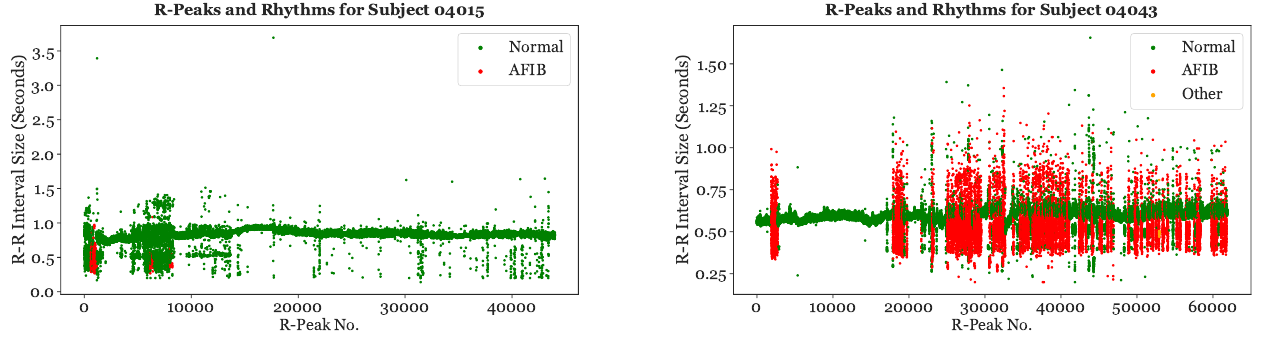
Figure 6. Labeled rhythms for Subject 04015 and Subject